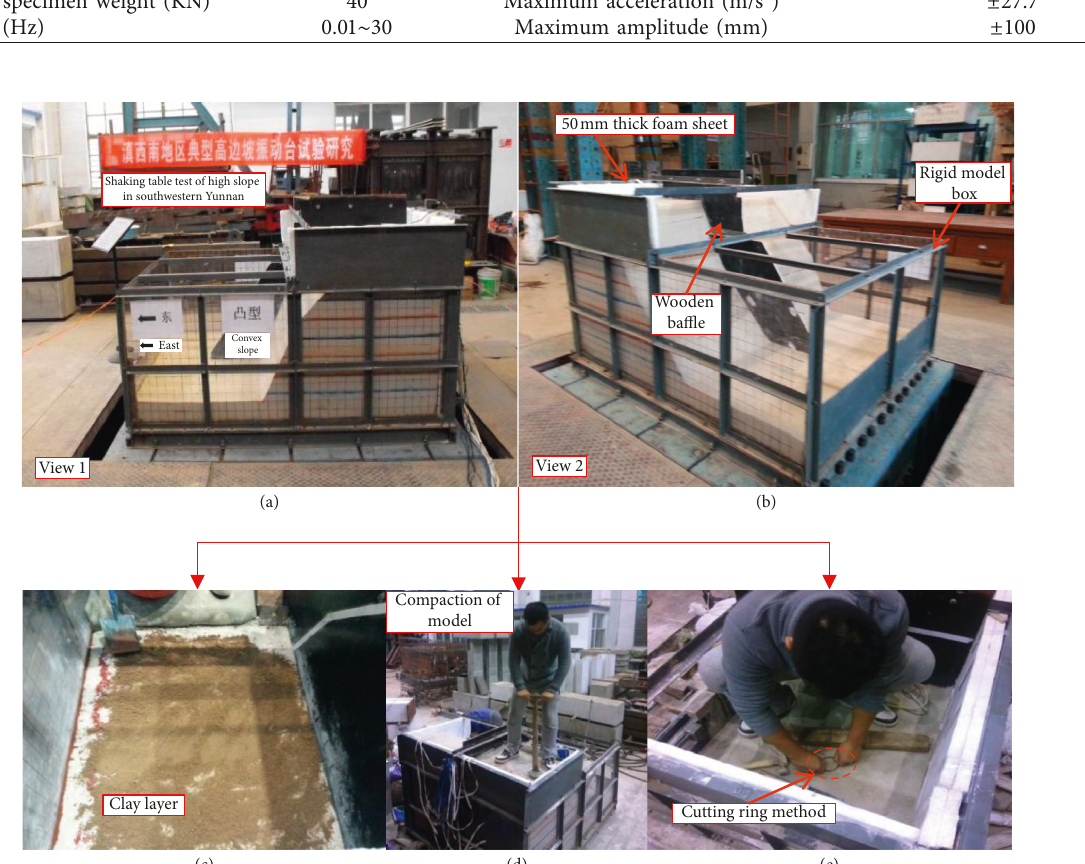
Figure 4: Photos of completed models and the key steps of model construction. (a) View 1 of finished models. (b) View 2 of finished models. (c) Laying of muddy interlayer interface. (d) Compaction of model. (e) Cutting ring